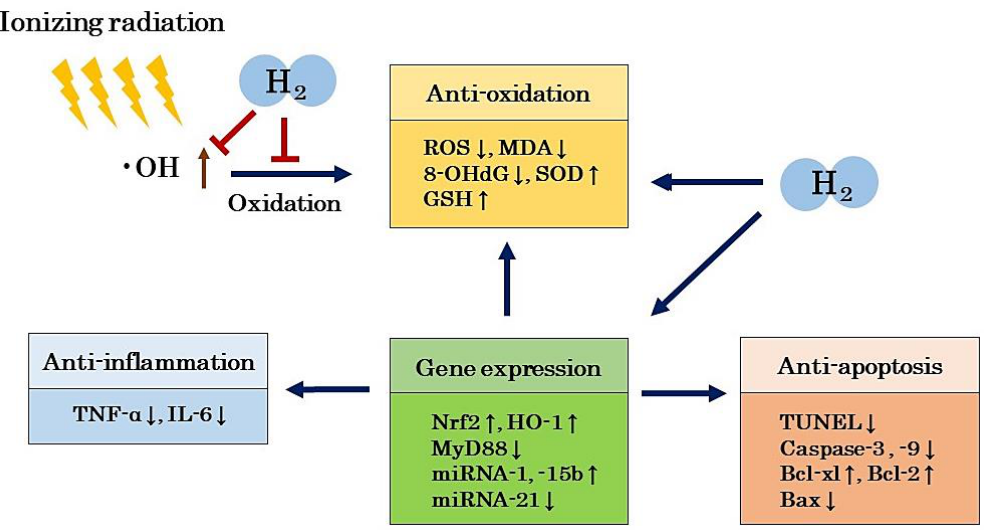
Figure 2. H 2 not only has a direct radioprotective effect by scavenging • OH, but also indirectly by regulating gene expression, exhibiting antioxidant, anti-inflammatory, and anti-apoptotic effects, which may lead to radioprotective effects. H 2 : molecular hydrogen; • OH: hydroxy radical; ROS: reactive oxygen species; GSH: glutathione; TNF- α : tumor necrosis factor- α ; IL-6: interleukin-6; Nrf2: nuclear factor erythroid 2-related factor; HO-1: heme oxygenase-1; TUNEL: terminal deoxynucleotidyl transferase-mediated dUTP nick-end labeling; Bcl-xl: B-cell lymphoma-extra-large; Bcl-2: B-cell lymphoma-2; Bax: BCL2-associated X protein; MyD88: myeloid differentiation factor 88; miRNA: microRNA.